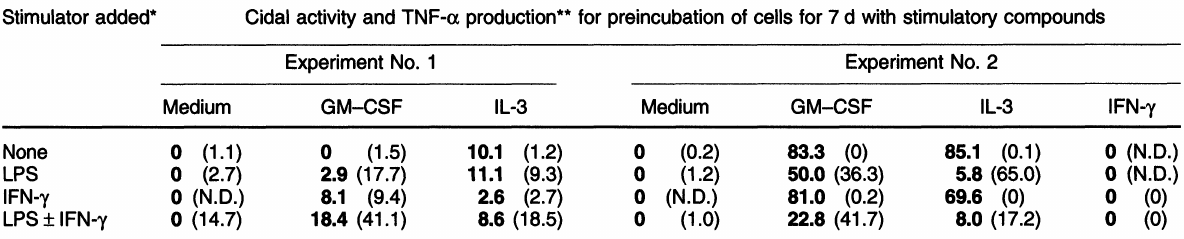
Table 2. Correlation between TNF-x production and schistosomulicidal activity of human monocytes/macrophages Stimulator